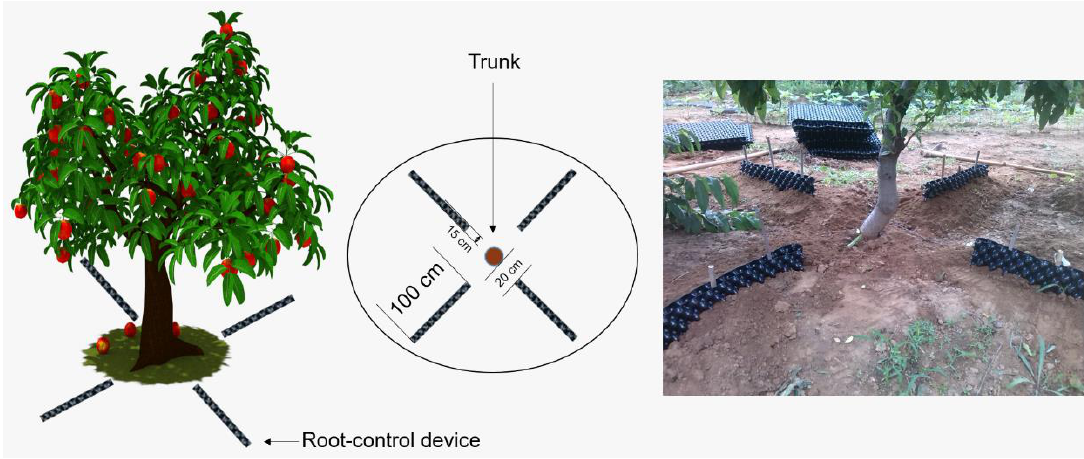
Figure 1. Root-zone aeration device and treatment schematic.